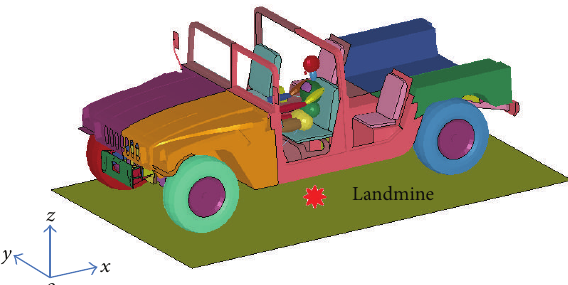
Figure 4: Simulation model of a crewed military vehicle under a landmine